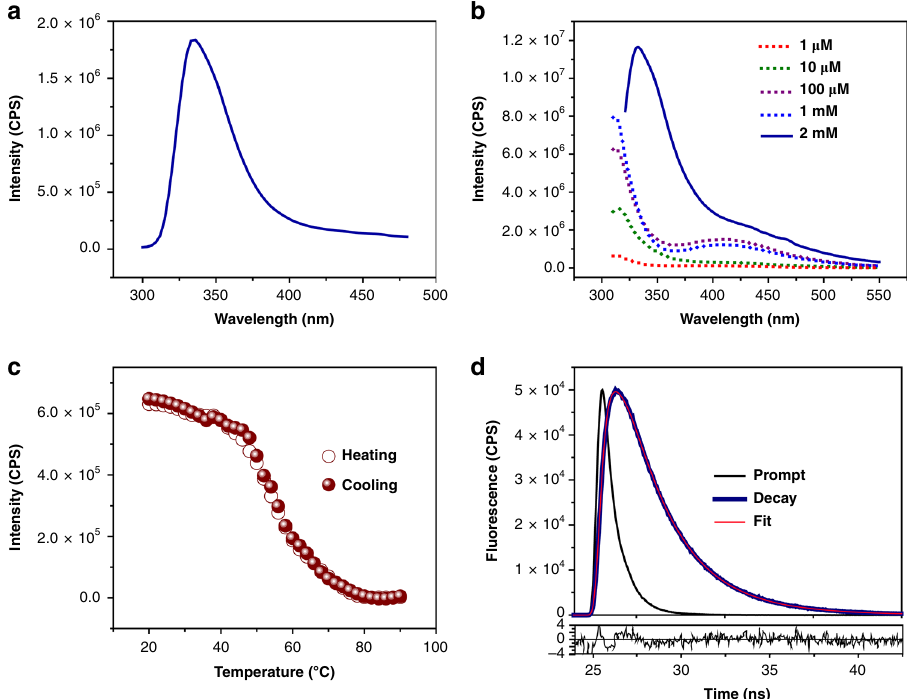
Fig. 3 Fluorescence characterization of Fmoc-G-PNA tetramer. a Fluorescence emission spectrum of assemblies at λ ex = 280 nm. b Fluorescence emission spectra in solution at various concentrations, λ ex = 290 nm. c Fluorescence melting pro fi le obtained by monitoring emission at 330 nm under λ ex = 290 nm. d Fluorescence decay curve of crystals excited at λ ex = 280 nm and probed at 330 nm, along with the corresponding residuals Table 1 Fitting parameters derived from the fl uorescence decay of Fmoc-G-PNA tetramer using tri-exponential functions λ (nm)